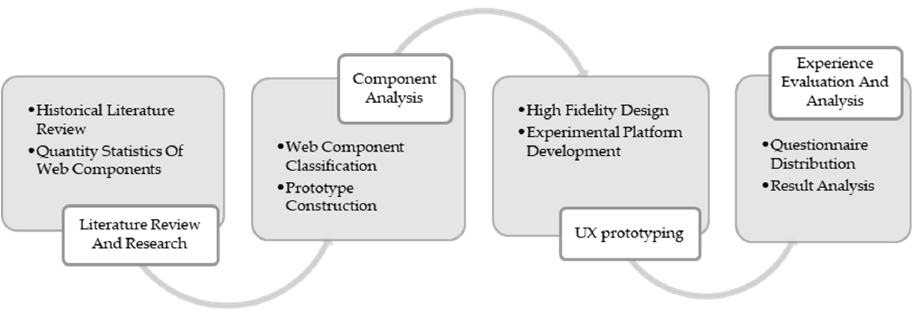
Figure 1. Research strategy phases.